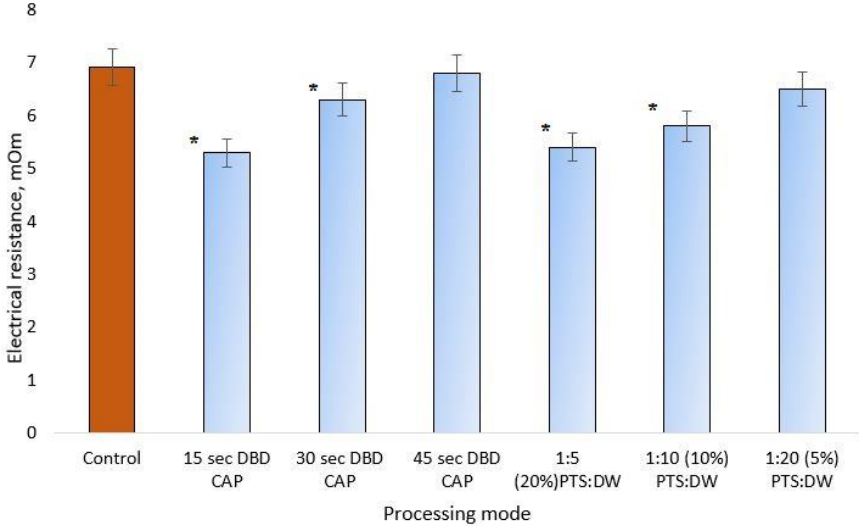
Figure 12. Specific resistance of plant tissues in the grafting zone. * Indicates a significant difference at 5% level in comparison with the control.